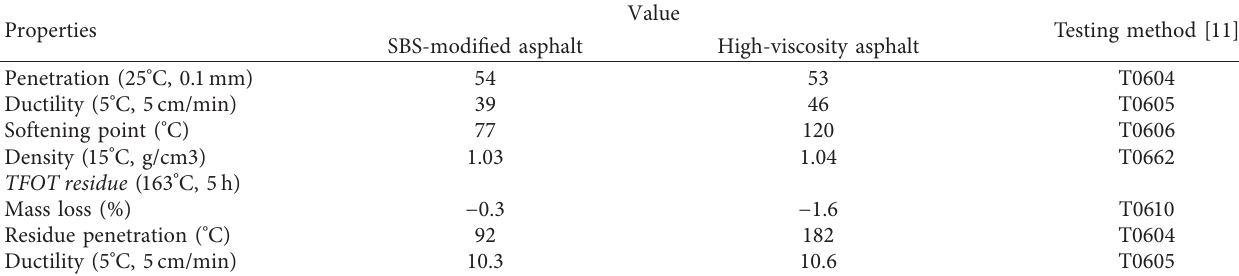
Table 2: Properties of SBS-modified asphalt and high-viscosity